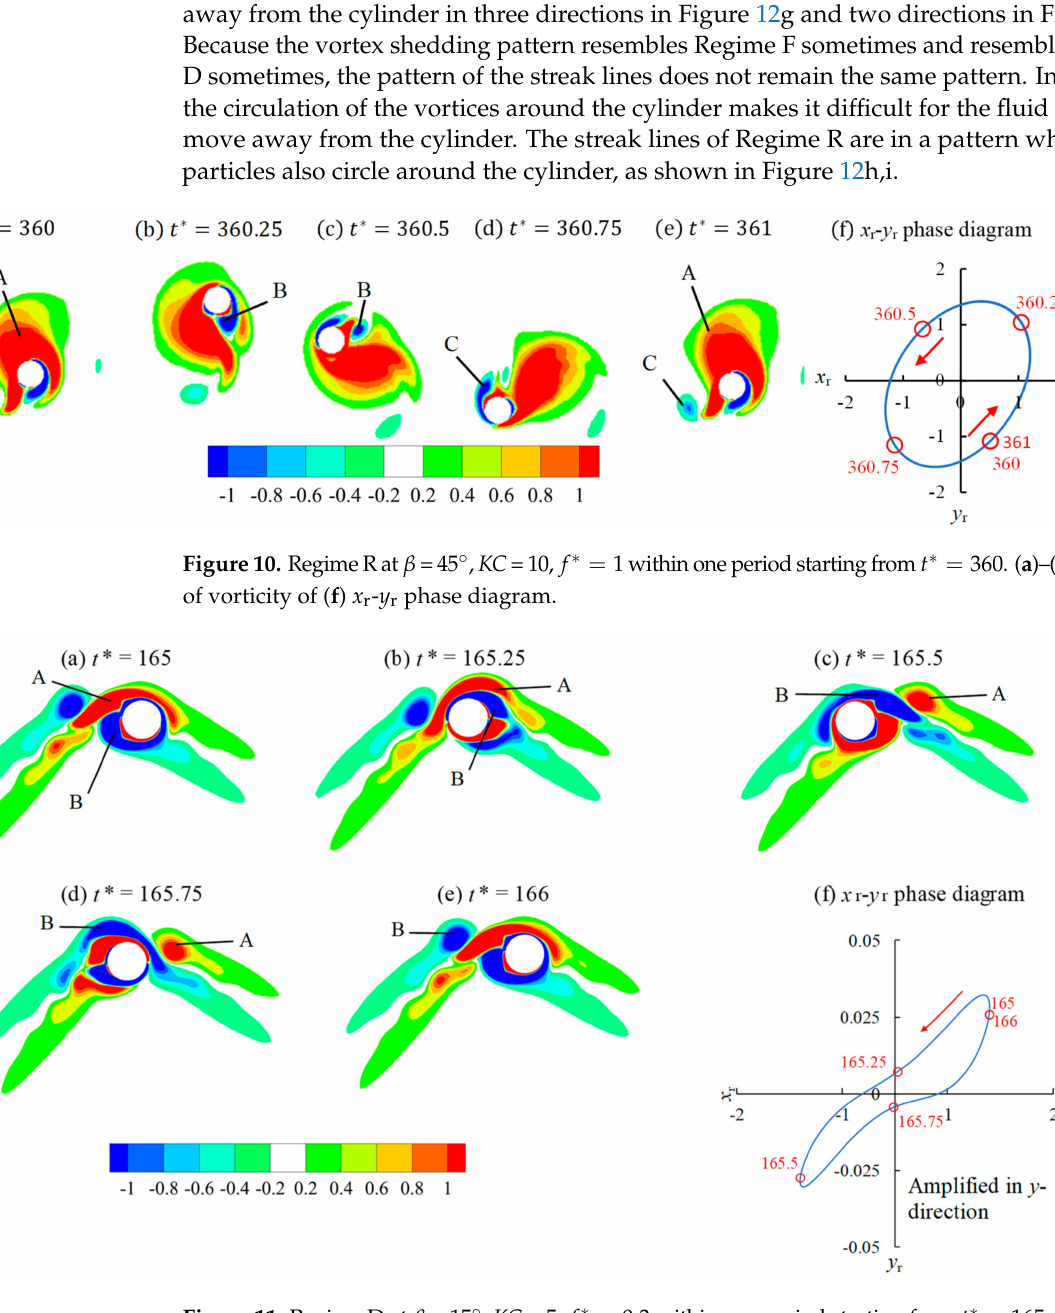
Figure 11. Regime D at β = 15 ◦ , KC = 5, f ∗ = 0.3 within one period starting from t ∗ = 165. ( a )–( e ) Con- tours of vorticity of ( f ) x r - y r phase